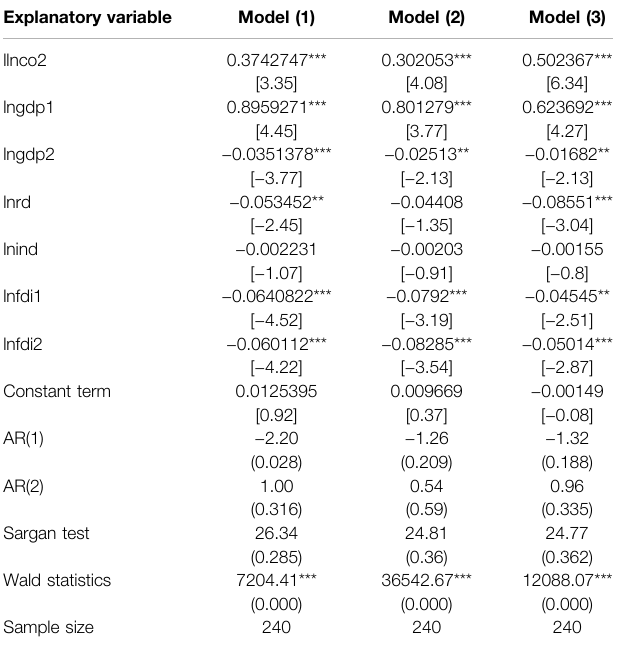
TABLE 3 | Dynamic threshold regression